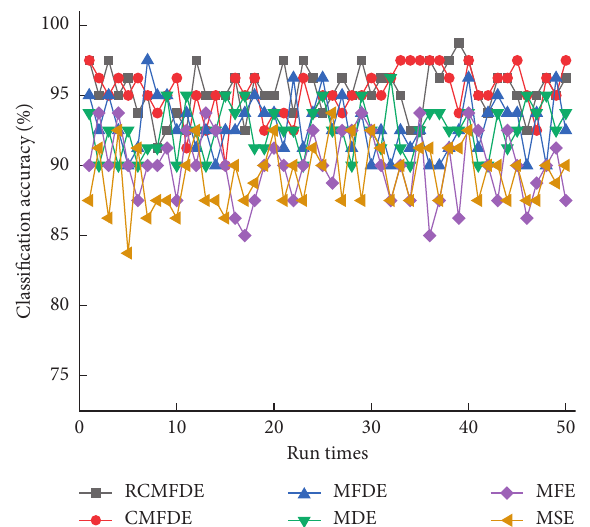
Figure 14: Classification accuracy of different methods without PSO-VMD. Table 7: The accuracy of different methods without PSO-VMD. Different